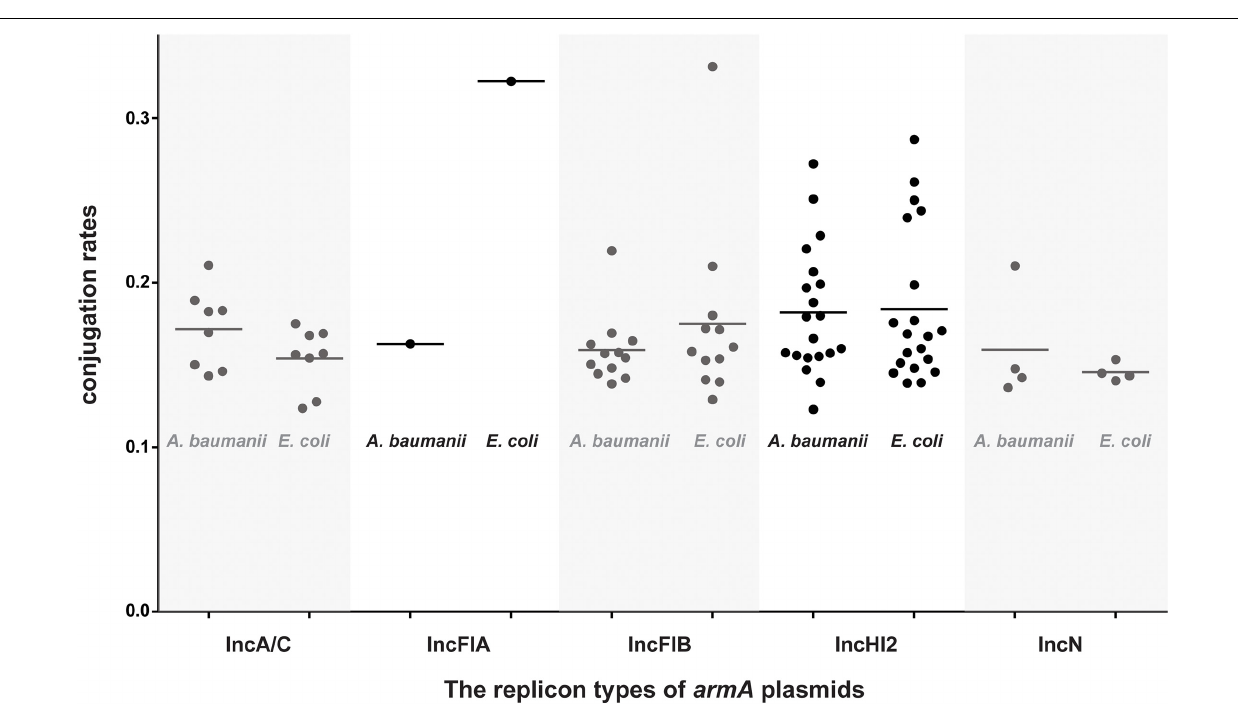
Frontiers in Microbiology |